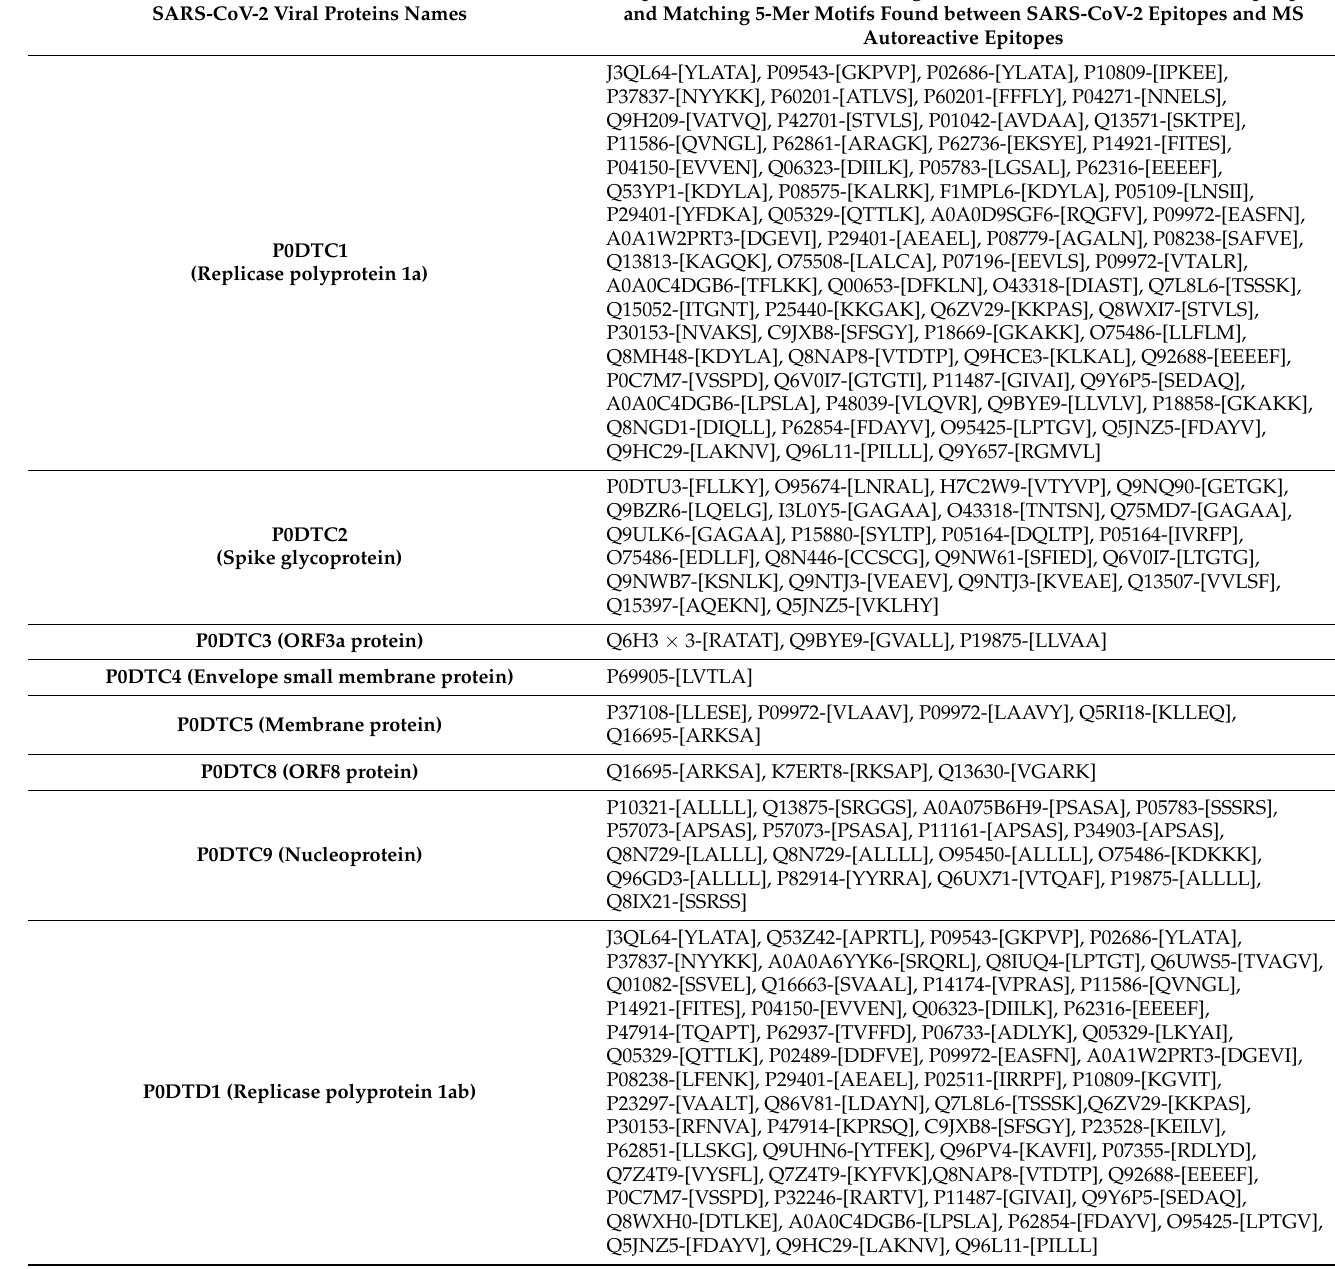
Table 5. Matching 5-mer linear motifs found in epitopes against SARS-CoV-2 viral proteins that are also present in autoreactive epitopes against self-protein found in